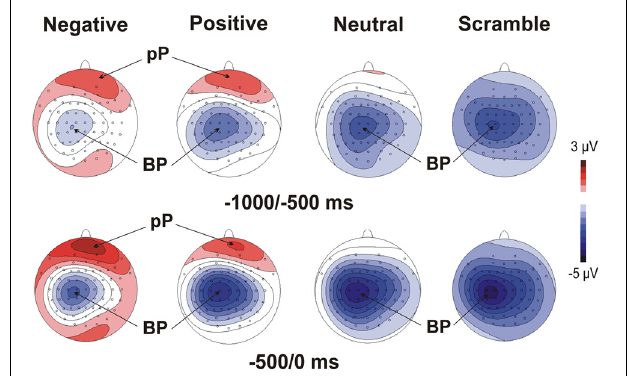
FIGURE 2 | Scalp topographies (top-flat view) of the grand average of the MRCPs in the four experimental categories. The maps display the mean amplitude on the scalp in two time windows before the